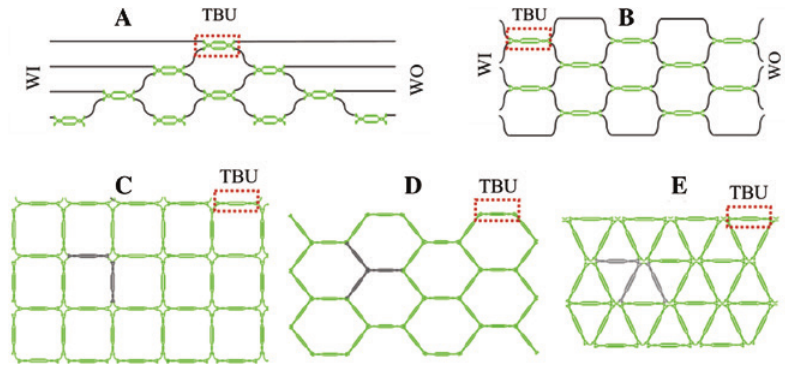
Figure 1: Different arrangements of beamsplitters to implement integrated waveguide meshes. (A) Triangular feedforward proposed by Reck et al. [13] and reformulated by Miller [4], (B) rectangular feedforward proposed by Clements et al. [14], (C) squared feedforward/backward [9], (D) hexagonal feedforward/backward [10, 23] and (D) triangular feedforward/backward [10, 23]. WI/WO, waveguide inputs/outputs.